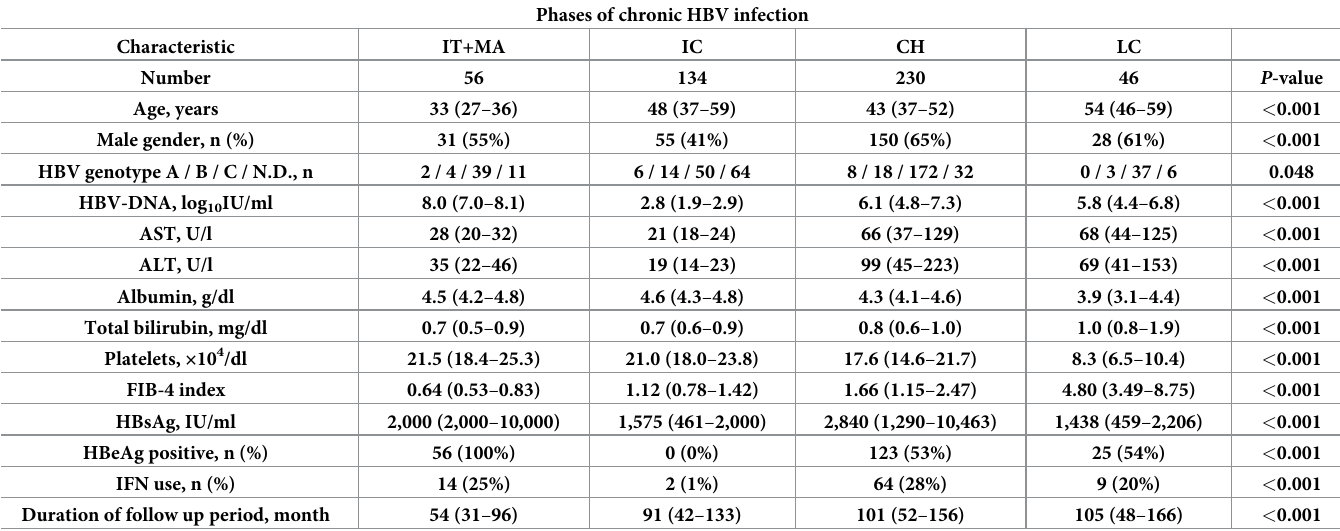
Table 1. Baseline clinical characteristics of the patients in the various phases of chronic hepatitis B virus